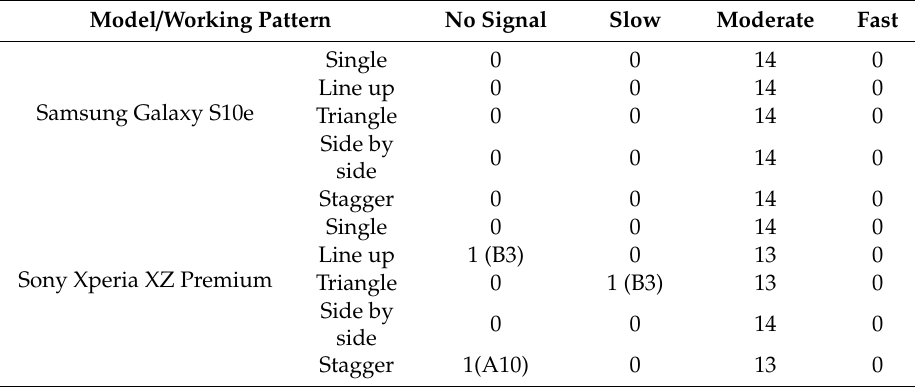
Figure 15. Di ff erent walking patterns of user. Figure 15. Different walking patterns of user. Table 5. The volunteers’ feedback on Table 5. The volunteers’ feedback on responsiveness.